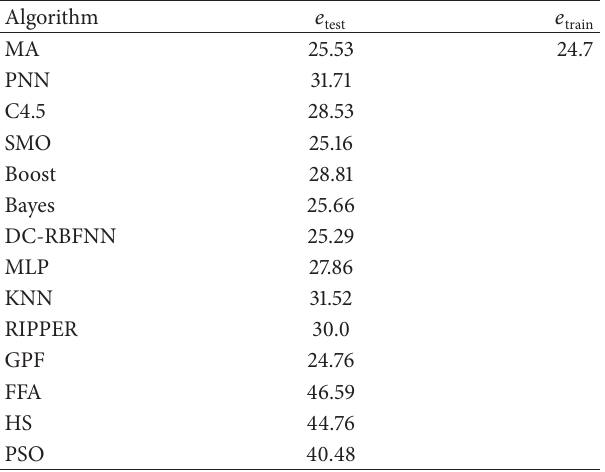
Table 7: Results in the German Numer